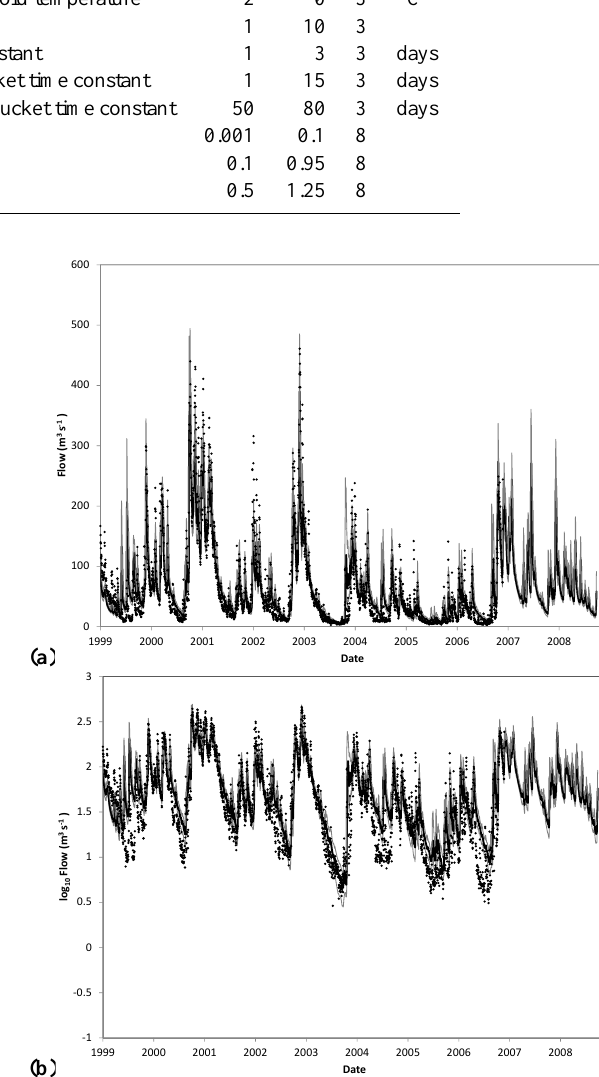
Fig. 7. (a) Observed (dots), maximum, average and minimum sim- ulated flows at Teddington, the lowermost site simulated in the present study (Reach 8). (b) Plot of log 10 transformed observed, maximum, average and minimum modelled flows at Teddington (reach